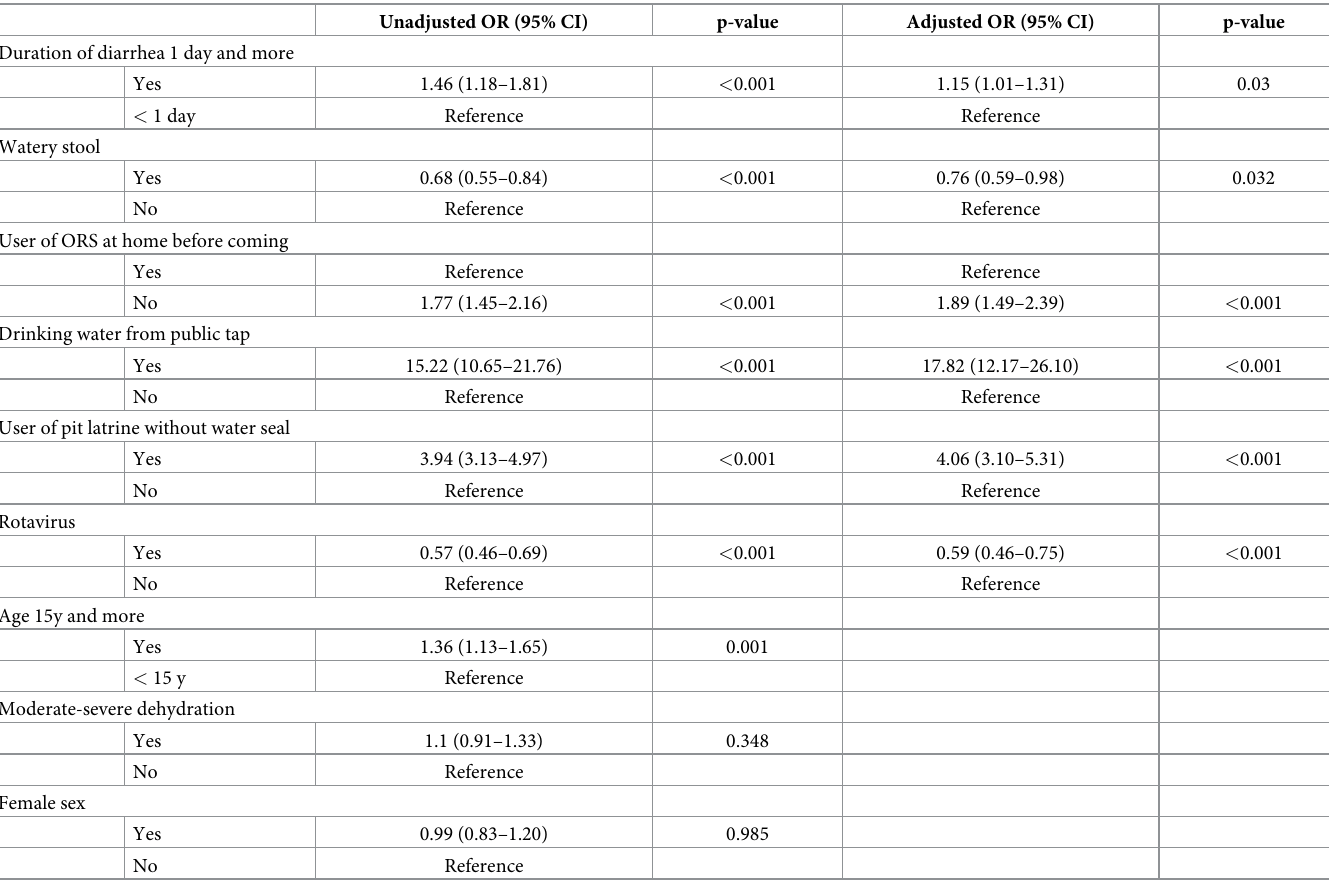
Table 6. Factors associated with hospitalization of displaced population from settlements in DTCs, April—December 2018, Cox’s Bazar,